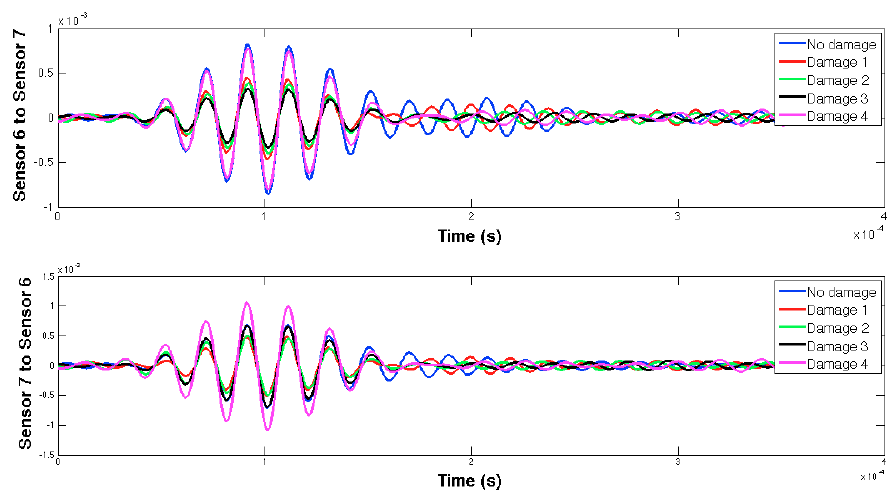
Figure 23. EMPD at 50 kHz. Tone-burst sent and measured between sensors 4 and 6.